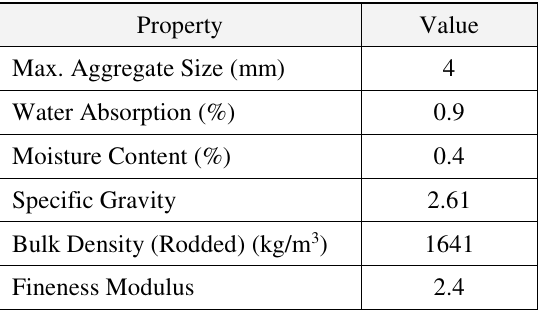
Table 1: Properties of fine aggregates (Sand)